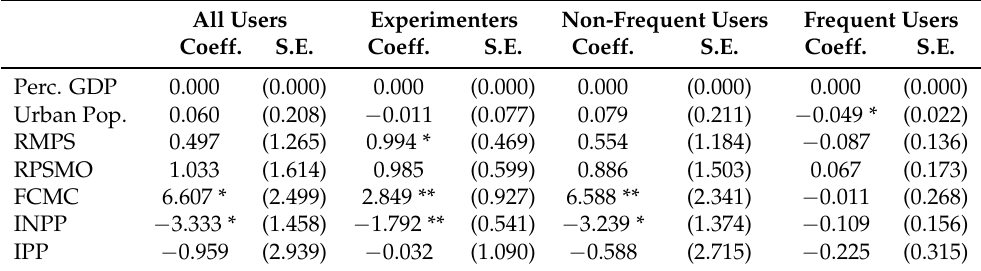
Table 5. Estimated association between cannabis policy reforms and changes in past-year prevalence of all cannabis users, experimental, non-frequent and frequent users. All Users Experimenters Non-Frequent Users Frequent Users Coeff. S.E. Coeff. S.E. Coeff. S.E.